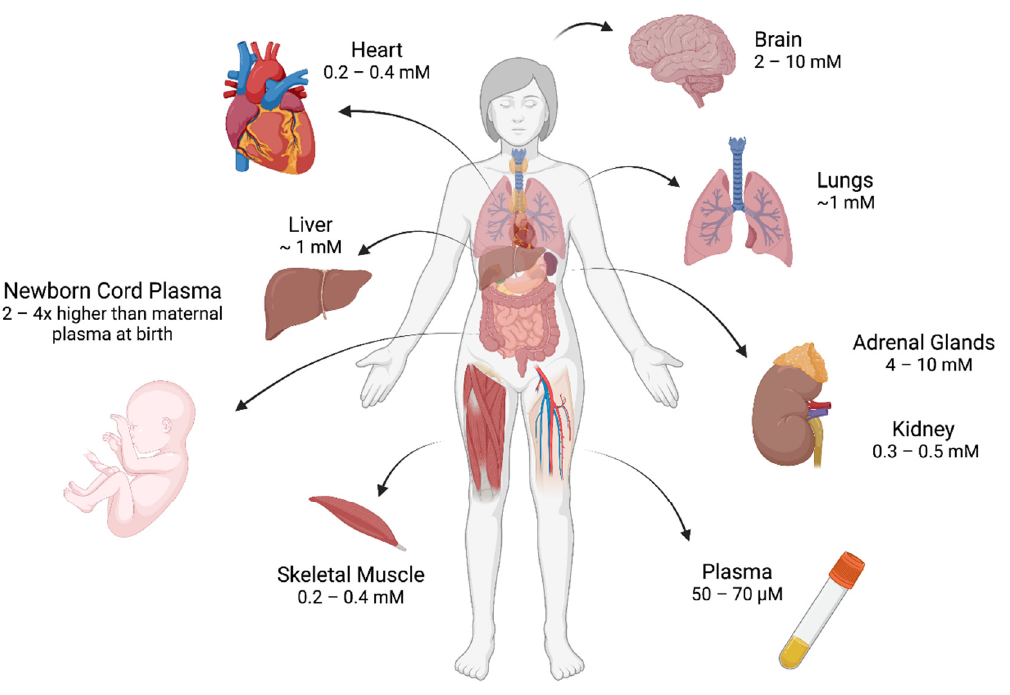
Figure 1. Tissue Distribution of Vitamin C. Vitamin C is present at different concentrations in different tissues. Notably, the concentration of vitamin C is particularly high in the brain and adrenal glands [19], with the newborn retaining higher plasma concentrations of vitamin C that its mother at the time of birth [8]. These observations highlight the importance of understanding the role of vitamin C during neurodevelopment. Figure created with Biorender.com using published data [19].